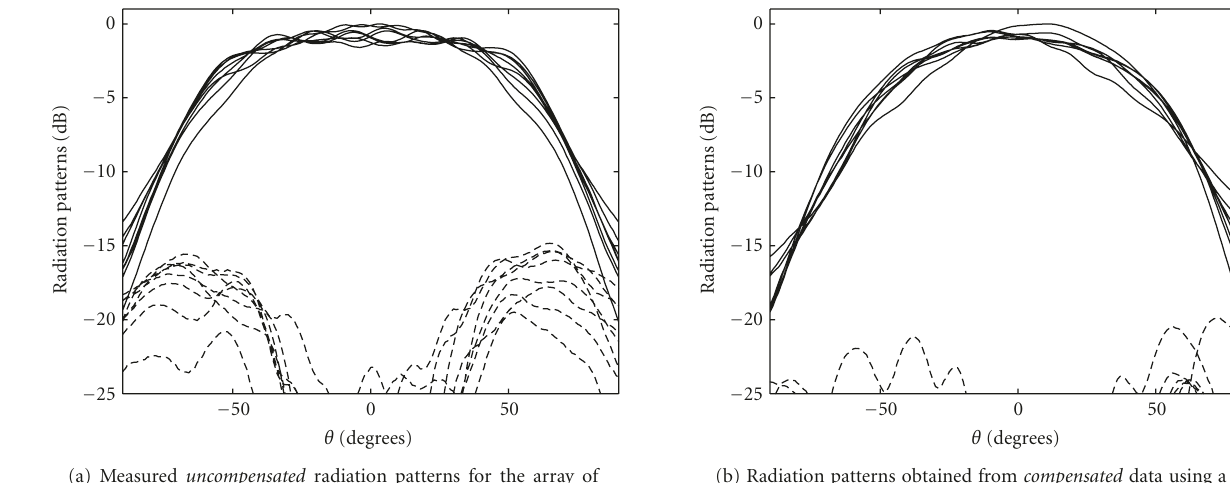
(b) Radiation patterns obtained from compensated data using a C matrix estimated via our algorithm setting K = 1 (i.e., forcing E ∝